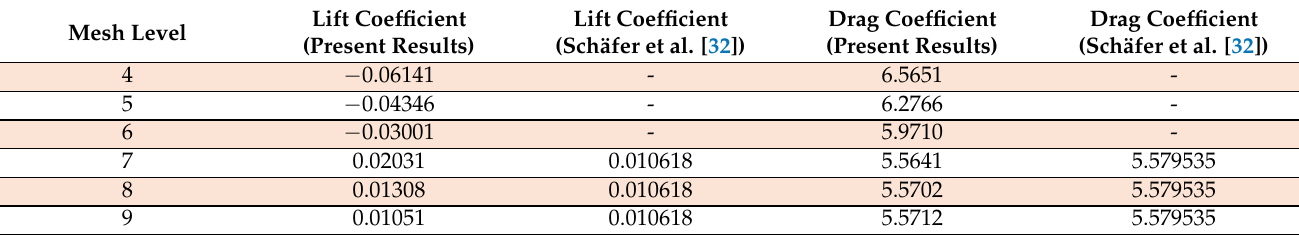
Table 11. Coefficient comparison with Schäfer et al. [32] at Re =